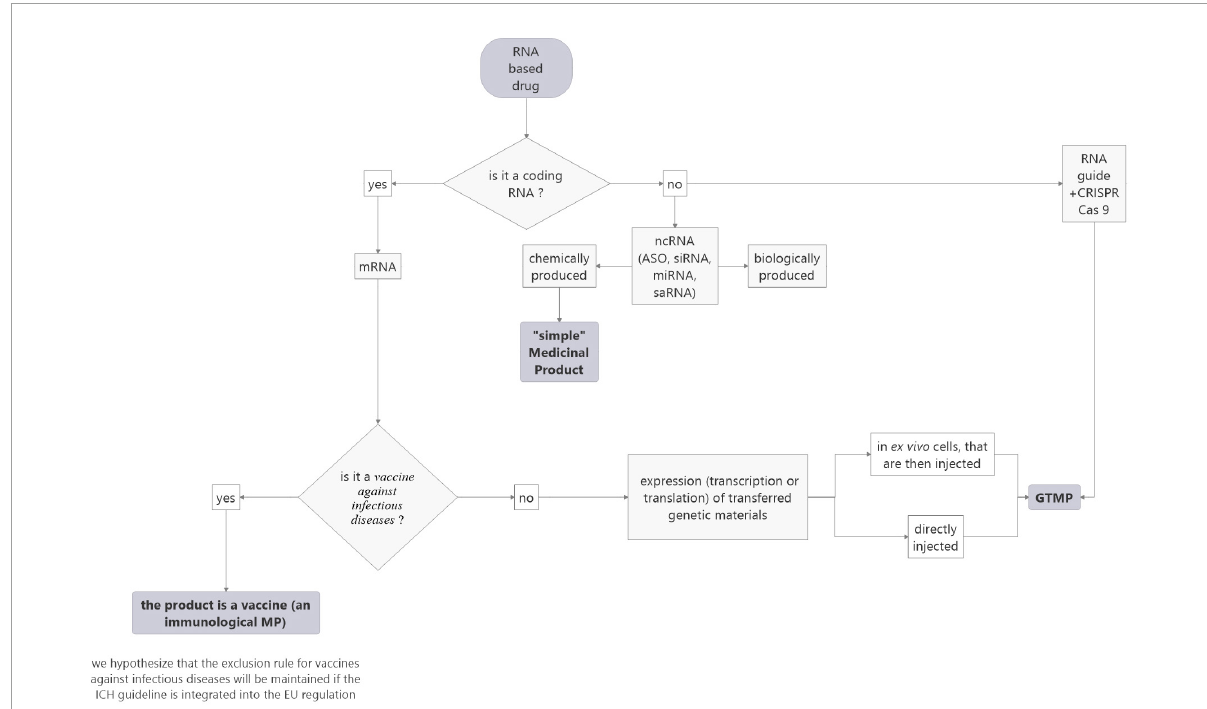
FIGURE4 Proposed flowchart to facilitate the categorization of RNA-based medicinal products according to the ICH rules